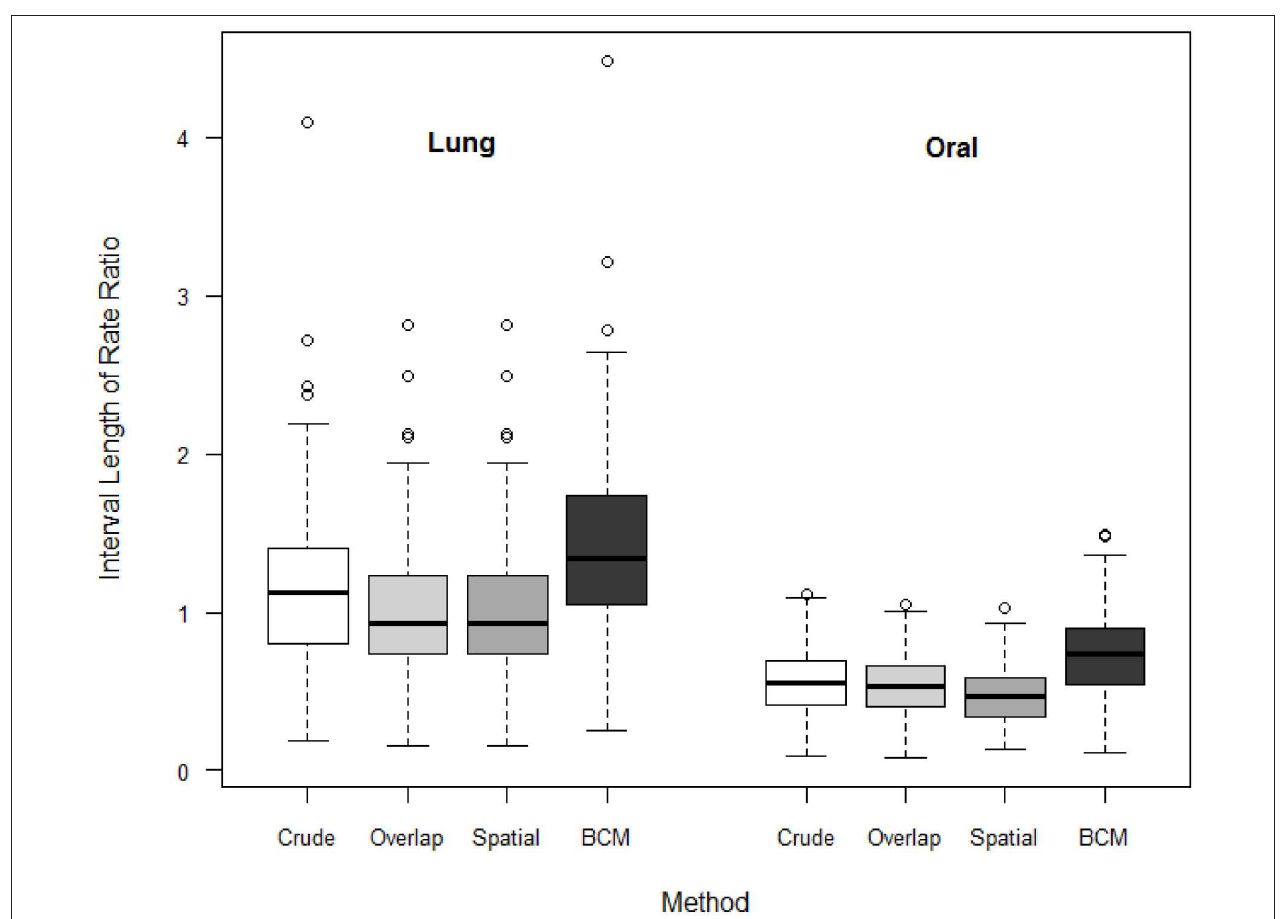
FIGURE 7 | Boxplot of lengths of 95% CI for Rate Ratio by cancer site (oral or lung cancer) and